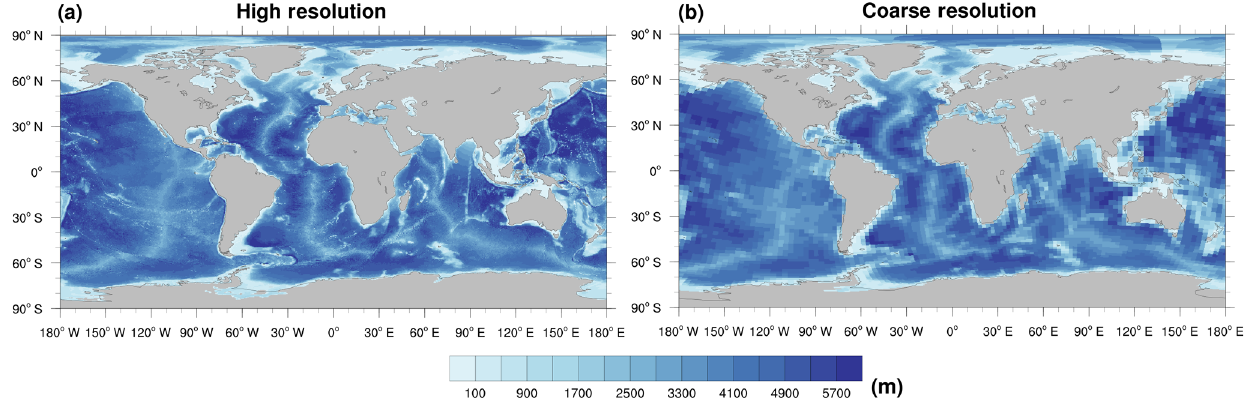
Figure 2. Present-day global ocean bathymetry (m) and land-sea mask for (a) the high-resolution (HR, 10 (cid:48) × 10 (cid:48) ) dataset; and (b) the generated coarse-resolution (GR30) grid for running MPIOM.